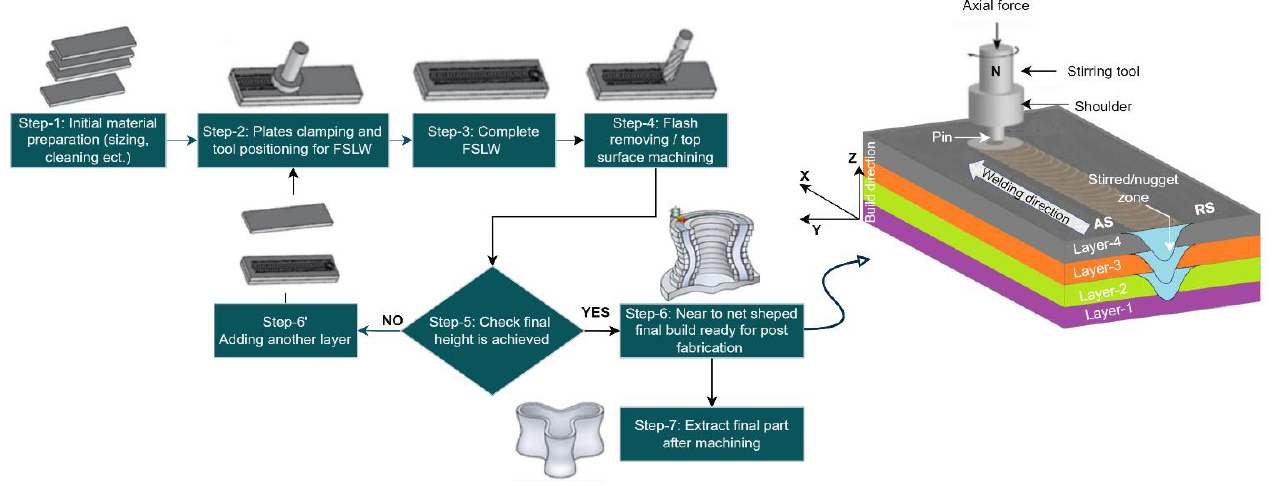
Figure 5. FSAM schematic illustration and final four-layered build obtained.